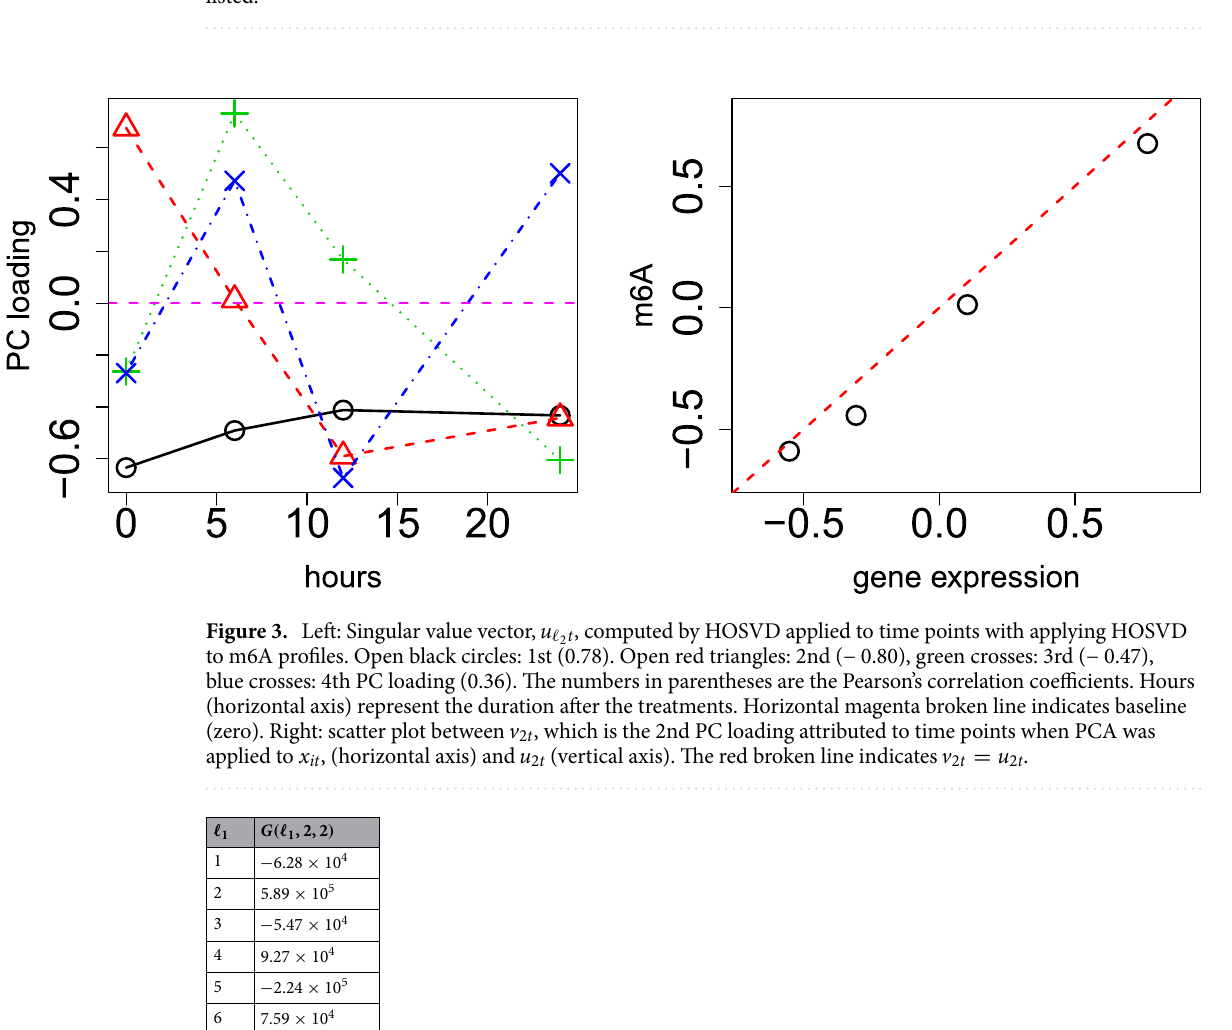
Table 3. “GO Biological Process 2018” category of Enrichr for 52 genes selected by applying PCA-based unsupervised FE to gene expression profiles. Six glucose-related terms with adjusted P -values less than 0.05 are listed.